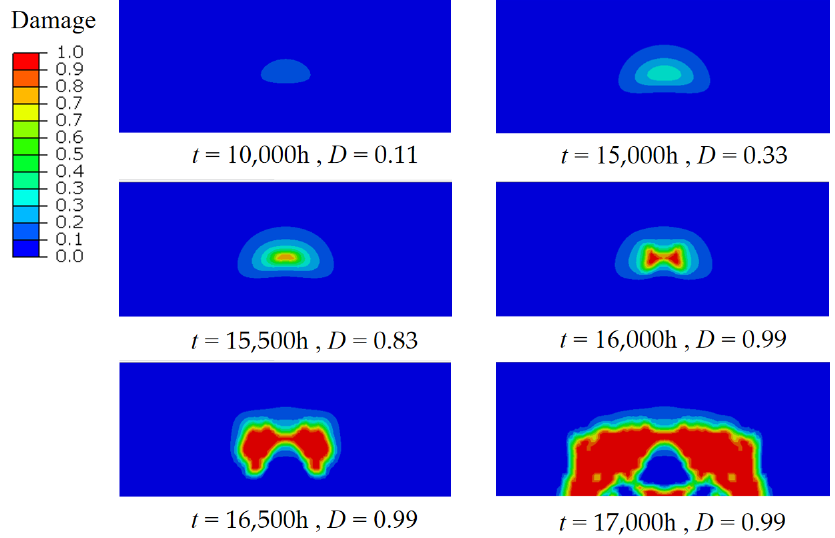
Figure 7. Damage evolution of main raceway of main bearing outer ring.